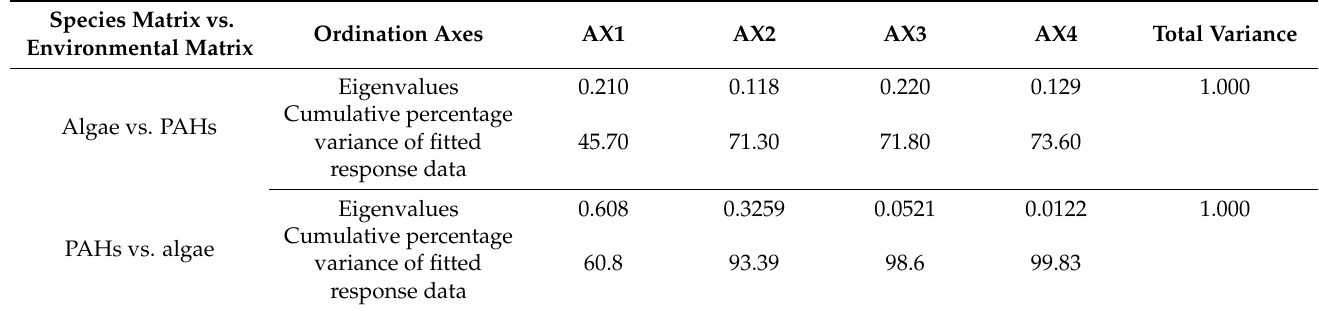
Figure 5. Redundancy analysis (RDA) ordination tri-plot of algae species, sampling sites, and PAHs residues in algae. ( A ) Ordination results when the algae abundance acts as the species matrix and residual PAHs concentrations represent the environmental matrix. The data matrices in ( B ) are opposite those in ( A ). Circles symbol is the sample sites; the arrows are PAHs in ( A ) or the species of algae in ( B ). The length of the arrow corresponds to the importance of the variable. Table 2. Eigenvalues for RDA axis and the cumulative percentage